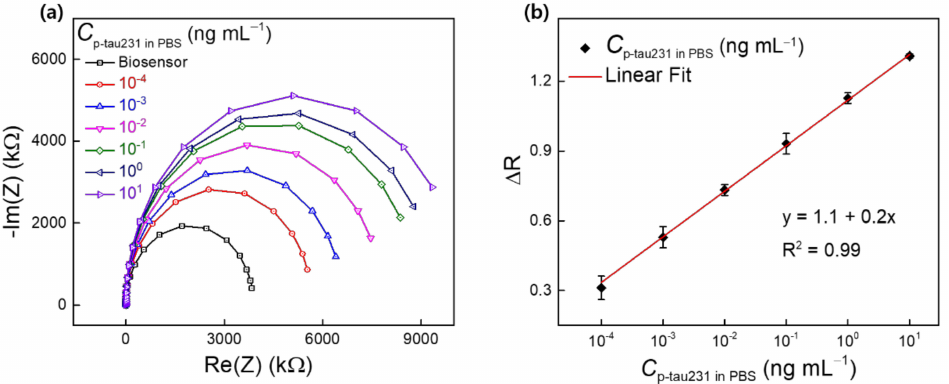
Figure 5. ( a ) Nyquist plots of the detection of p-tau231 in PBS (10 − 4 –10 1 ng mL − 1 ) using biosensor IWE/SAM/EDC-NHS/anti–p-tau231; ( b ) calibration curve for the detection of p-tau231 in PBS (10 − 4 –10 1 ng mL − 1 ) estimated from the normalization ( ∆ R) of R ct value in Nyquist plots. Symbols and bars represent the average and standard deviation of the data ( n = 3).